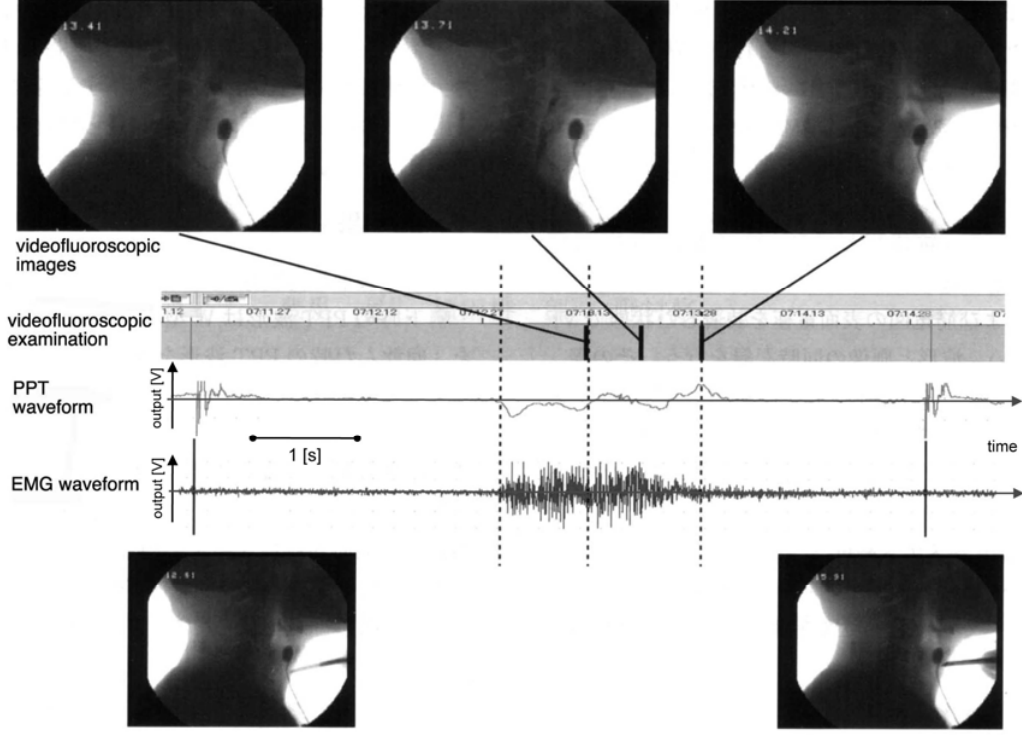
Figure 17. SVF images, PPT waveform, and electro-myographic data of suprahyoid muscles acquired simultaneously [59]. The measurements were synchronized by tapping the PPT with a metal rod before and after swallowing, as shown in the lower section of the